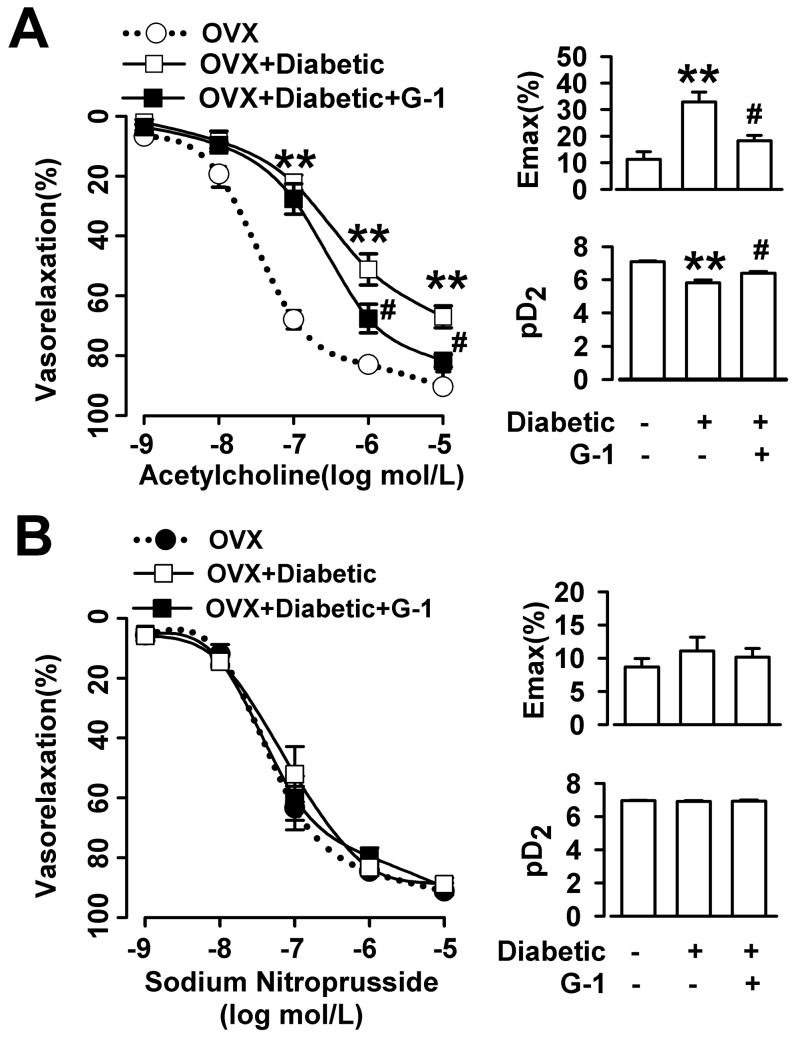
Effect of G1 on the relaxation response to ACh or SNP.(A) Capability of the relaxation induced by ACh (10−9 M to 10−5 M) was reduced in diabetic OVX rats as compared with OVX rats. Long-term administration of G1 (200 ug/kg i.p., 2/per day, 8 weeks) increased the capability of vasorelaxation as shown by the Emax and pD2. (B) The capability of the relaxation caused by SNP (10−9 M to 10−5 M) had no difference in the aortic segments among the three groups. n = 6–12 rings from 5–8 rats. **
p<0.01 compared with OVX rats; #
p<0.05 compared with diabetic OVX rats. Results are given as the mean ± SEM of three independent experiments.